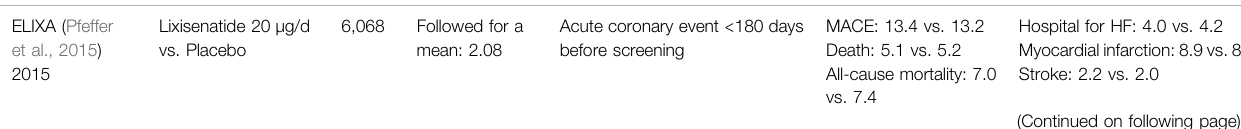
TABLE 2 | The effect of SGLT-2i on cardiorenal outcome and GLP-1RA on cardiovascular outcome. Groups n Duration Effect of SGLT-2i On Cardiorenal Outcomes in T2DM EMPA-REG Zinman et